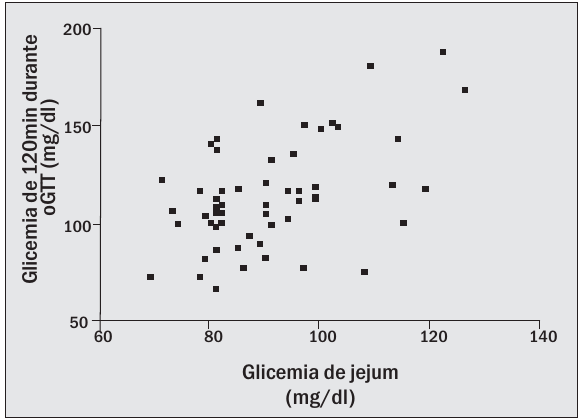
Glicemia de Figura 1 – Correlação entre glicemia de jejum e glicemia de 120 minutos durante o oGTT em 56 indivíduos (r = 0,48; p < 0,001)